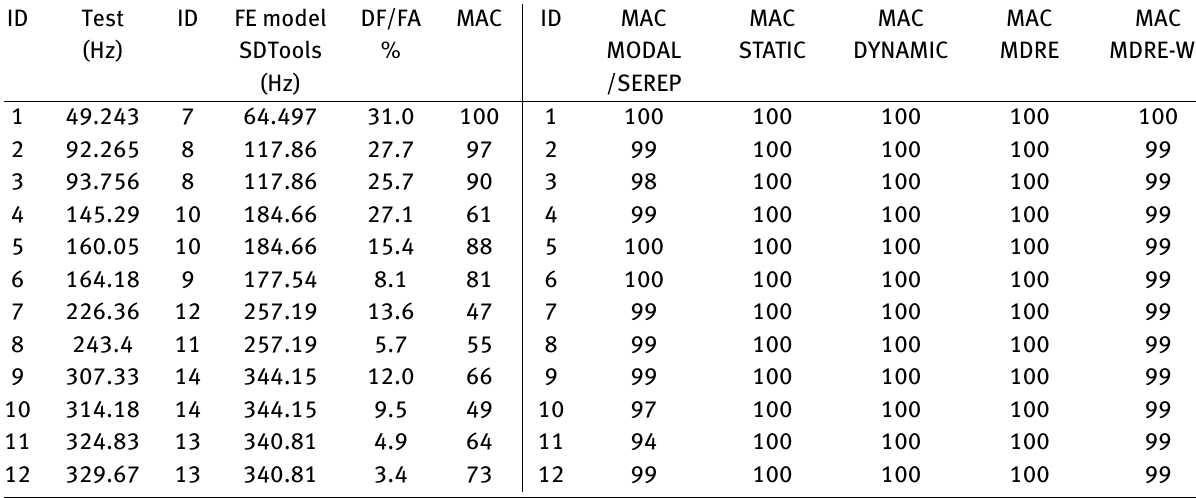
Table 6: Comparative MAC: Contrieved full model (SDTools) and MSE results vs. experimental measurements. ID Test